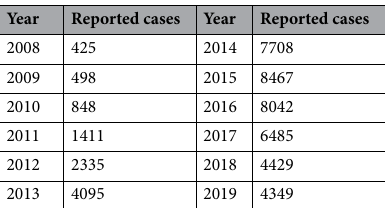
Table 1. The number of reported annual cases of human brucellosis in Xinjiang from 2008 to